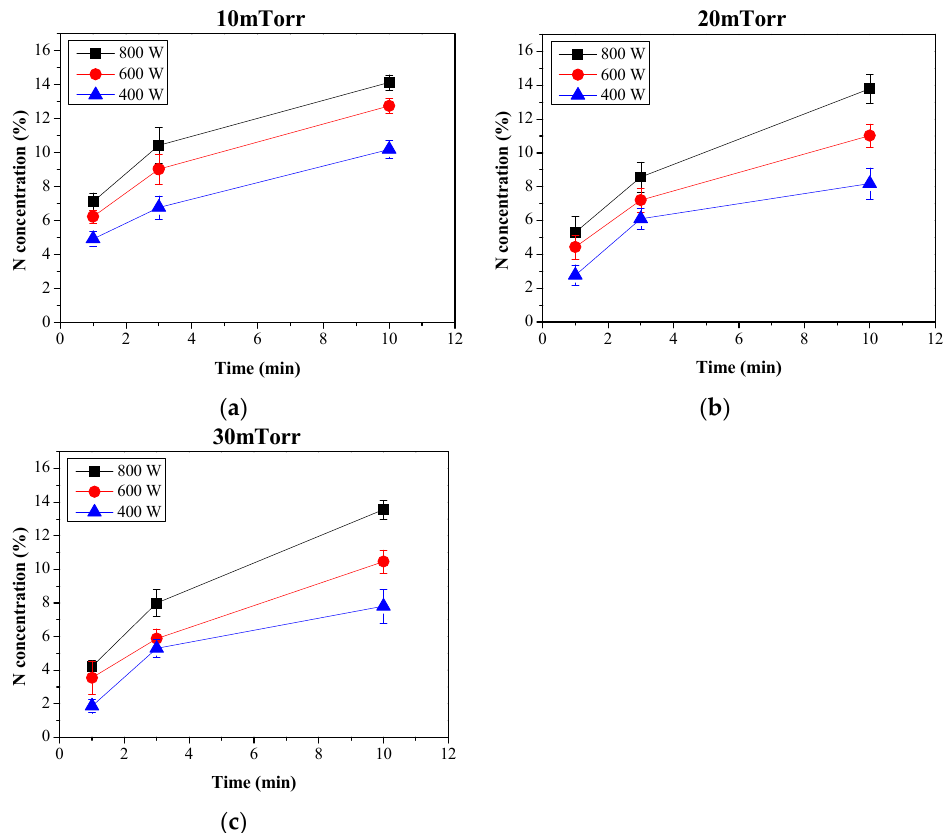
Figure 7. N concentration in the SiON film at ( a ) 10 mTorr, ( b ) 20 mTorr, and ( c ) 30 mTorr.